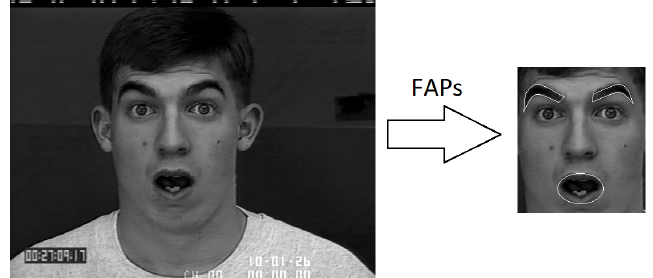
Figure 17. FAPs extraction using the CK+ database.